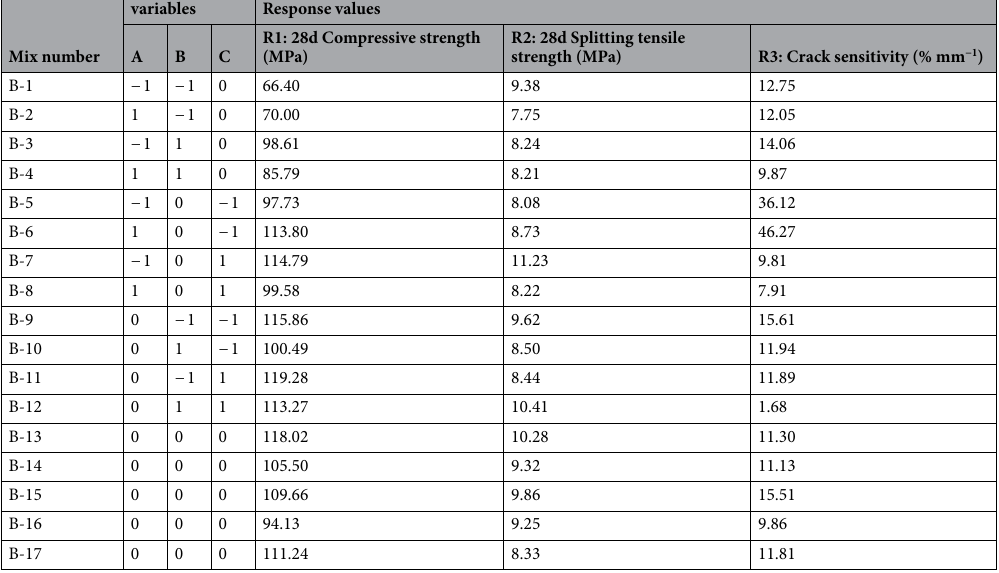
Table 4. Experimental factors and response results of the BBD matrix design.